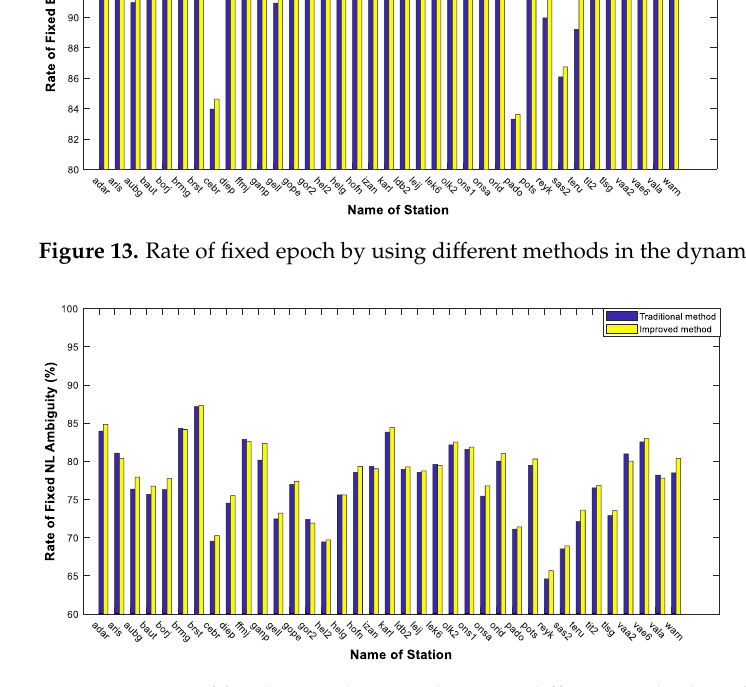
Figure 14. Rate of fixed NL ambiguities by using different methods in the dynamic model.